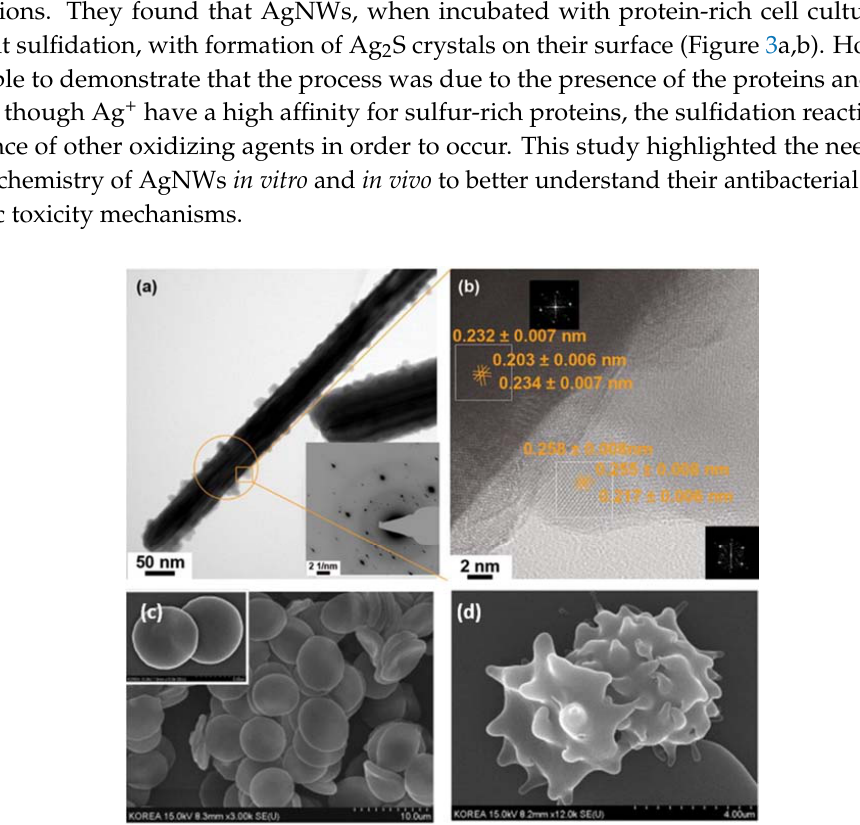
Figure 3. ( a , b ) Evidence of chemical modification of the AgNW surface in contact with cell culture medium; formation of Ag 2 S crystals [Reproduced from [71] with permission. Copyright (2013) ACS]. SEM images of ( c ) untreated erythrocytes with biconcave discocyte shape and ( d ) erythrocytes treated with AgNWs, presenting a echinocyte shape with evident spicules [Reproduced from [72] with permission. Copyright (2014)